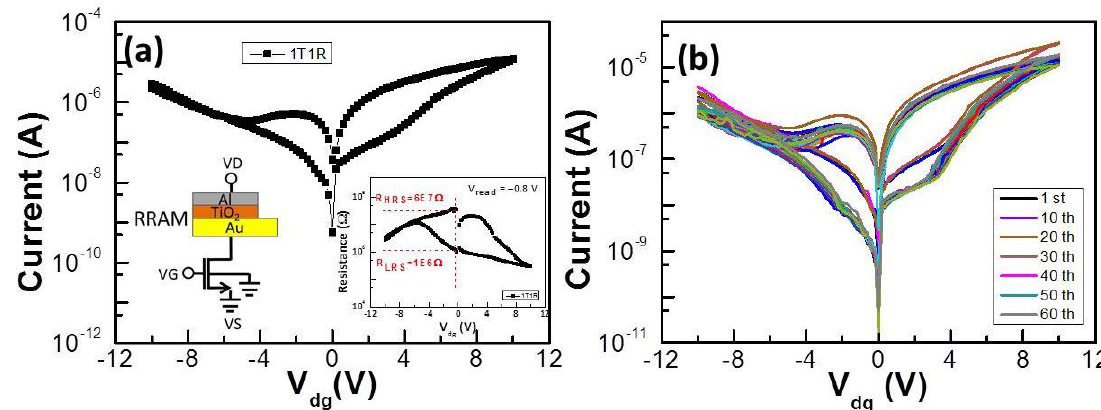
Figure 3. ( a ) I–V characteristics and schematics of the 1T1R (one-transistor and one-resistor) device. The inset shows the R–V (resistance-voltage) curve corresponding to Figure 3a; ( b ) Switching behavior of the 1T1R device cycles after 60 DC sweep cycles.